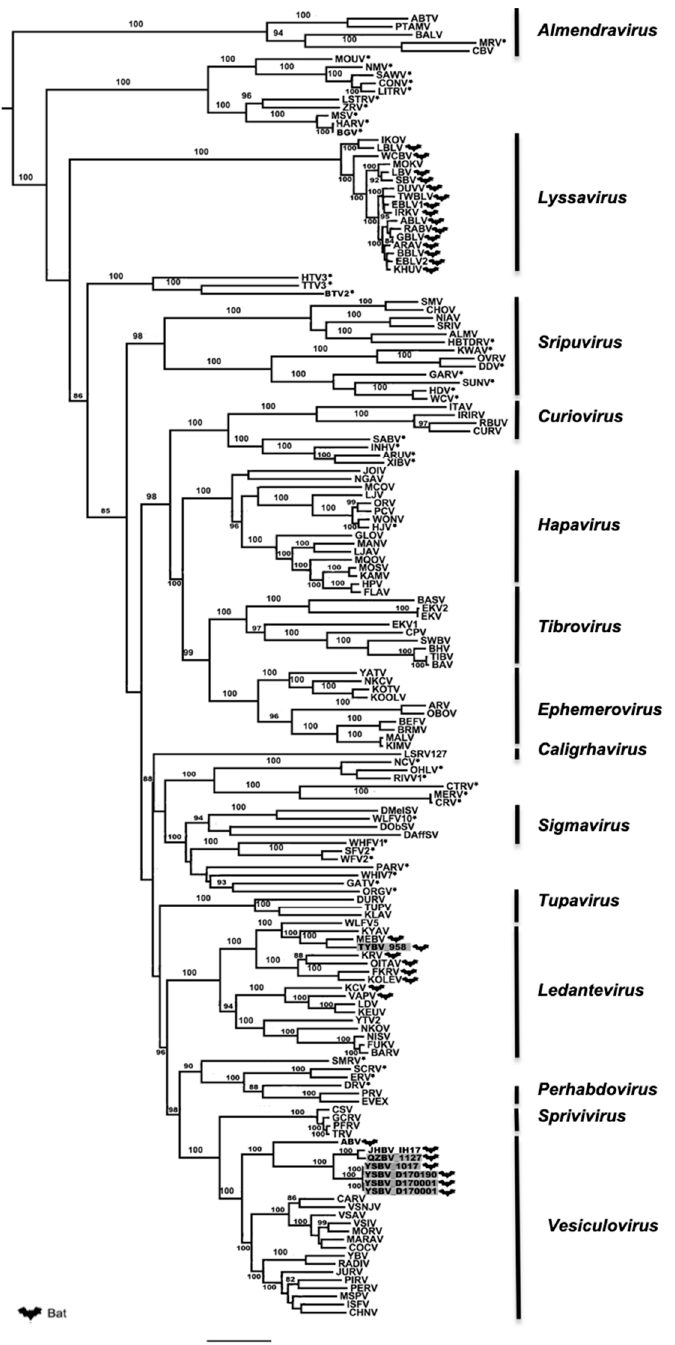
Figure 3. Phylogenetic classification of the sic Chinese bat rhabdoviruses. A maximum likelihood phylogenetic tree was done using MEGA7.0 on the full amino-acid sequence of the L protein includ- ing 155 previously reported rhabdoviruses from GenBank, using the LG+G+I+F model and with 1000 bootstrap replicates. Bat-related rhabdoviruses are indicated by a dedicated symbol. Unclassi- fied rhabdoviruses are indicated by asterisks. The Chinese bat rhabdoviruses described in this study are indicated in grey. All bootstrap proportion values (BSP) > 80% are specified. Scale bar indicates nucleotide substitutions per site.